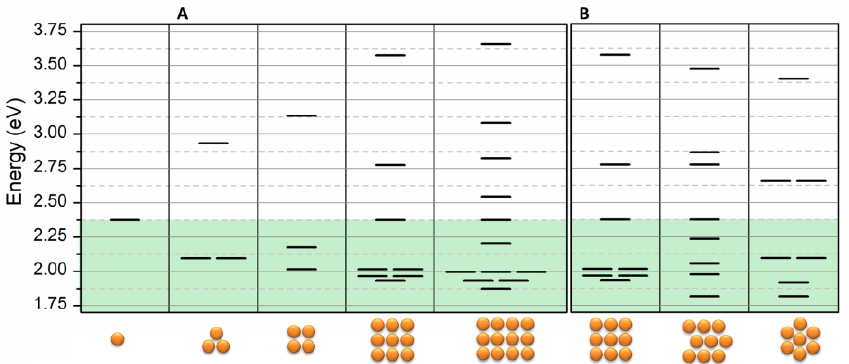
Table 2. Energy and wavelength of the peak of the resonance band for different cluster geometries